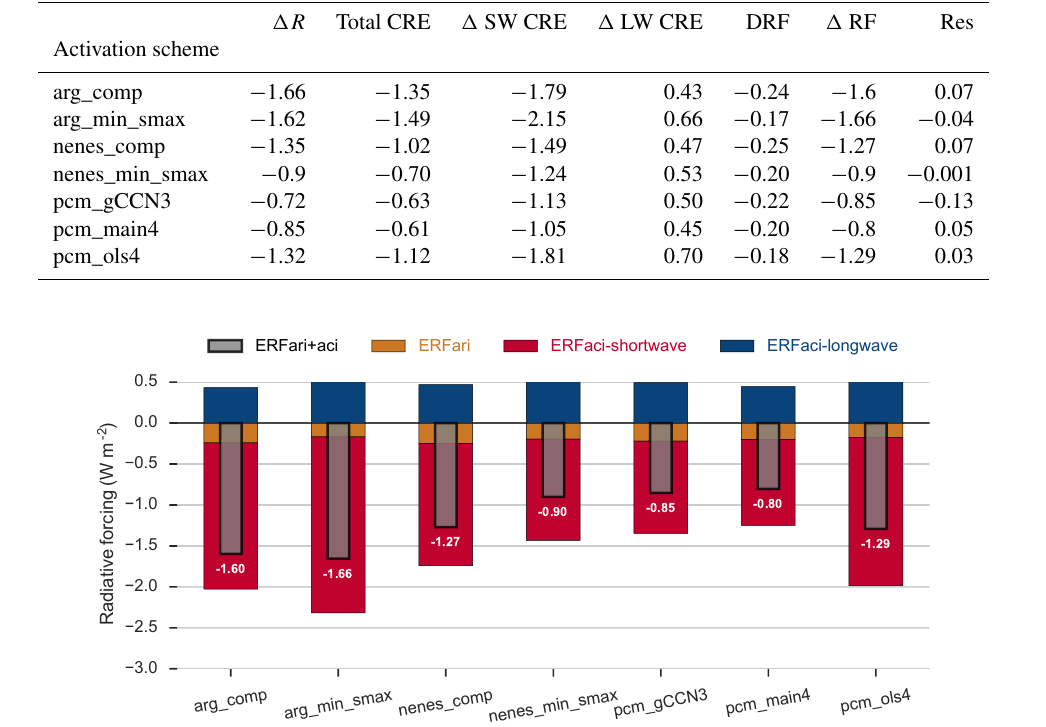
Figure 8. Global-average effective radiative forcing for aerosol direct radiative effects (ERFari) and indirect effects (ERFaci) in both the shortwave and longwave. The total effect is computed as the sum of the direct and both indirect